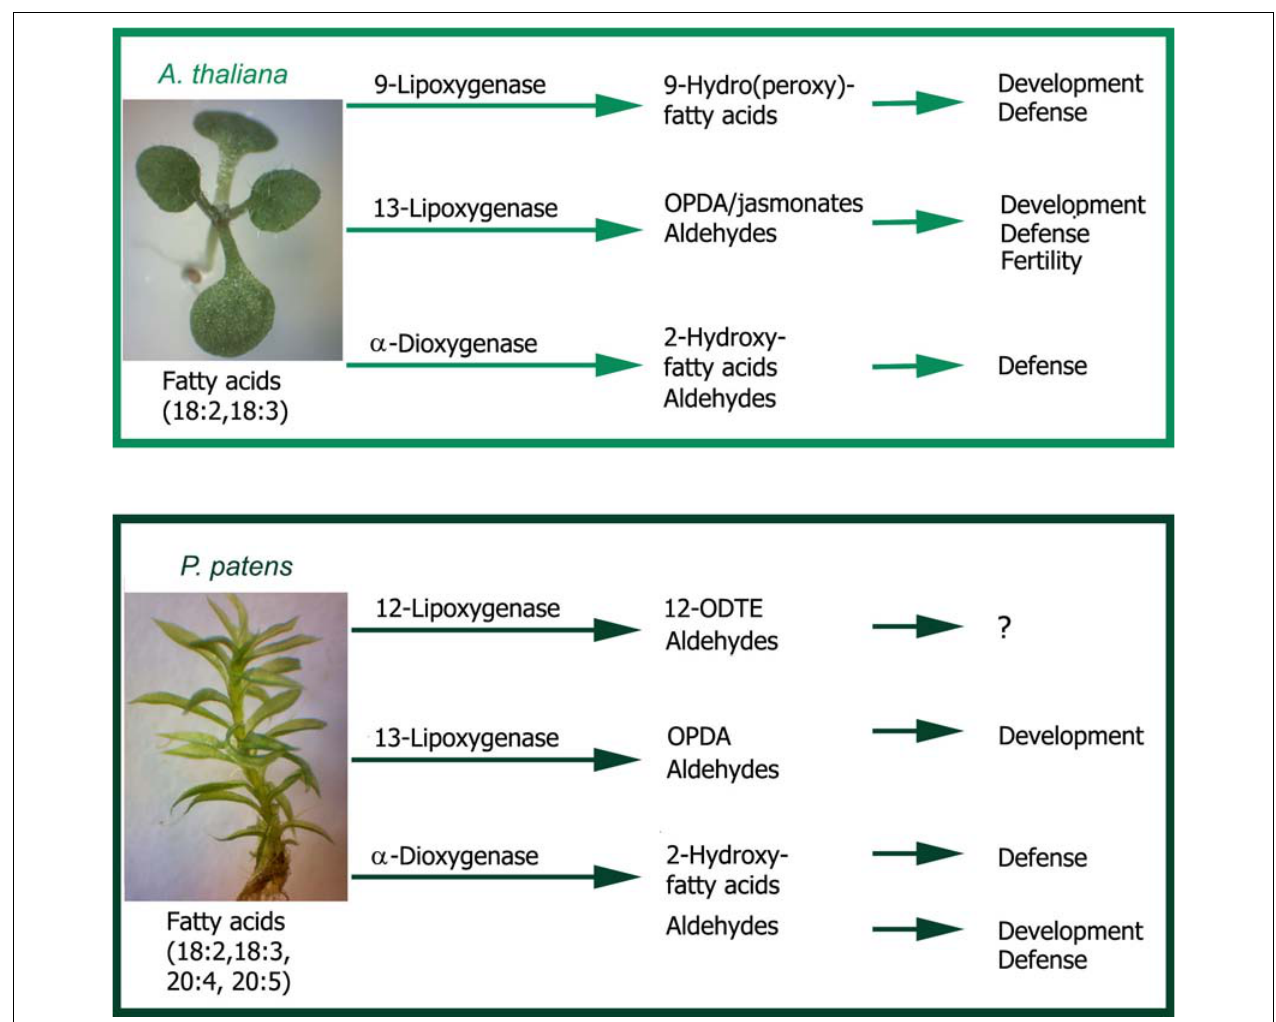
FIGURE 4 | Regulation of development and defense by plant oxylipins. Flowering plants like A. thaliana have 9-lipoxygenases and 13-ipoxygenases that catalyze the oxygenation of polyunsaturated fatty acids, mainly linoleic acid (18:2) and linolenic acid (18:3), to form fatty acid hydroperoxides. The resulting hydroperoxides are further metabolized to produce a variety of oxylipins, including hydroxy fatty acids and aldehydes, which play different roles in development and defense. α -Dioxygenase utilizes 18:2 and 18:3 to form 2-hydroperoxy fatty acids that are converted to 2-hydroxy fatty acids and aldehydes, with regulatory functions in plant defense against microbial pathogens and insects. The moss P. patens has besides polyunsaturated C18